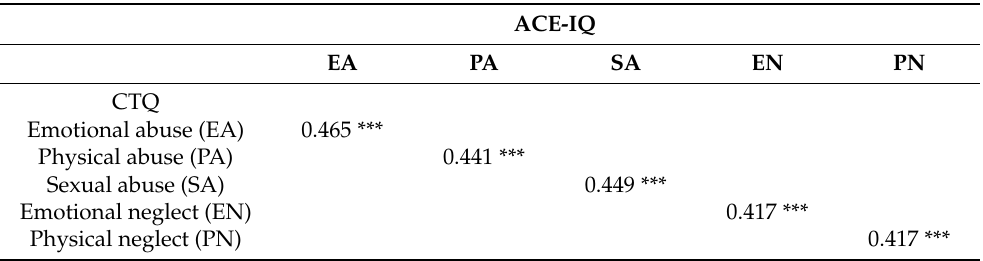
Table 4. Spearman nonparametric correlation coefficients between the subscales of the CTQ and the Adverse Childhood Questionnaire International Questionnaire (ACE-IQ) ( n =